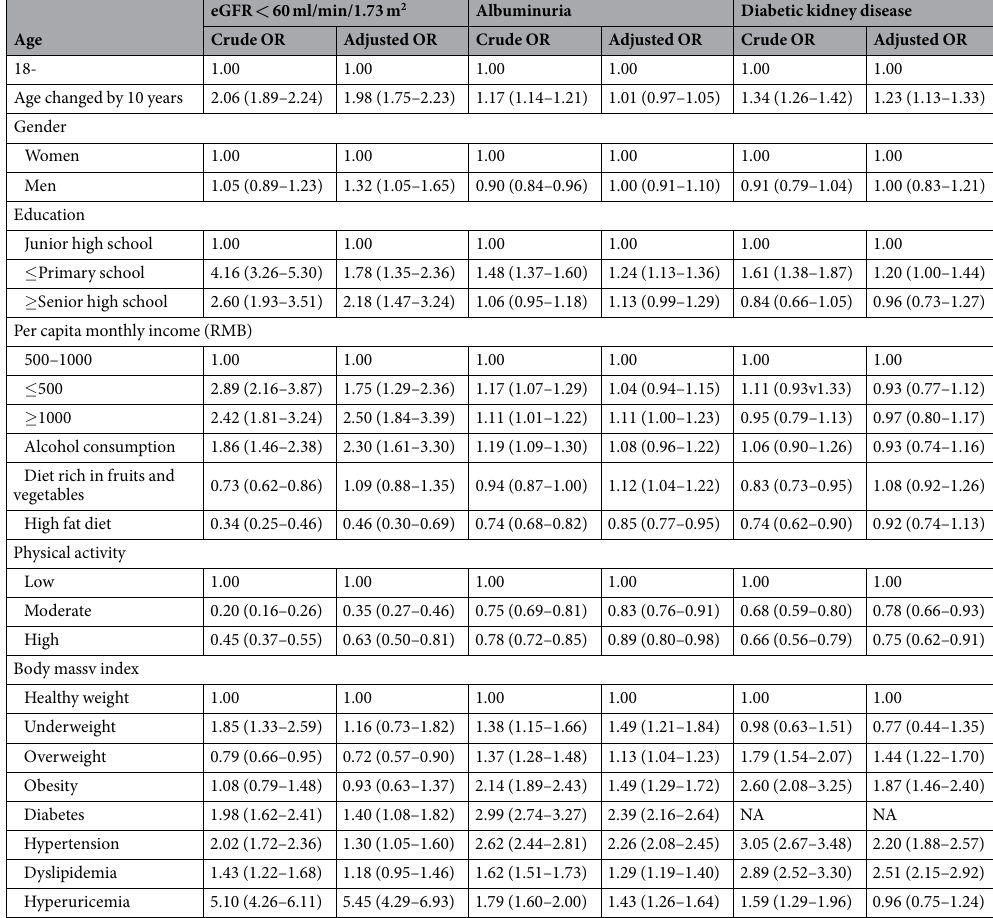
Table 6. Risk factors associated with indicators of renal damage and diabetic kidney disease Note: Data were crude and multivariable-adjusted odds ratio (95% Confidence Interval). Abbreviation: DKD, diabetic kidney disease; NA, not applicable Reference level: Gender = Woman; Education = Junior high school; Per capita monthly income = 500–1000; Alcohol consumption = No; Diet rich in fruits and vegetables = No; High fat diet = No; Physical activity = Low; Body mass index = Healthy weight; Diabetes = No; Hypertension = No; Dyslipidemia = No; Hyperuricemia =